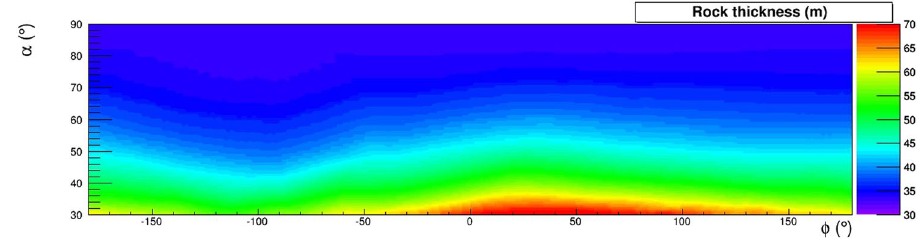
Figure 11. Rock thickness d ( α , φ ) crossed by muons reaching the detector under the hypothesis that no cavities are present, evaluated using the Digital Terrain Model. The drawing was obtained using the software root .